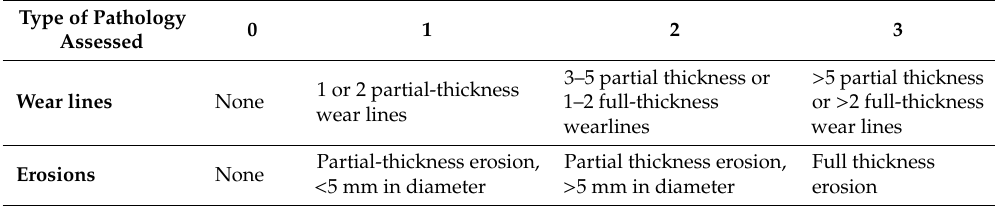
Table 4. Scoring system for macroscopic evaluation of equine joint surfaces